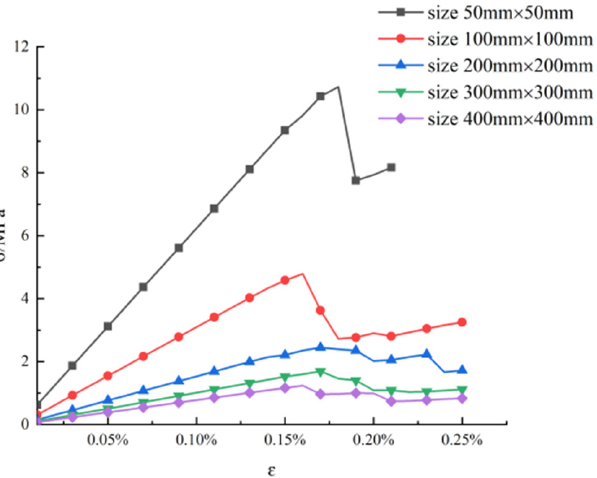
Figure 17. The stress–strain curve of different rock sizes when the parallel joint angle is 45°.